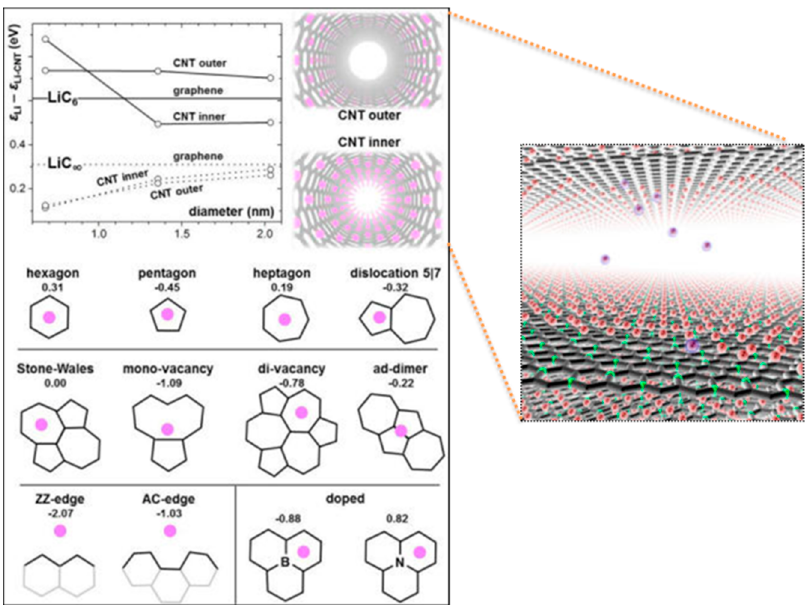
Figure 4. Energies and structures of Li adsorbed on carbon nanotubes (CNTs) and defects. The balls show Li, and the sticks represent C lattice. The numbers are calculated as ε Li − ε Li-M , in eV. The energy of a single Li atom adsorption on pristine graphene (hexagon) is also shown for comparison. The plots show ε Li − ε Li-CNT as a function of diameter for (5, 5), (10, 10), and (15, 15) CNTs, for adsorption on inner or outer surfaces, at high (LiC 6 , solid lines) or low ((LiC ∞ , dashed lines) concentrations [104].